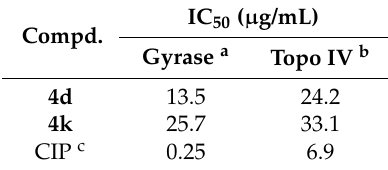
Table 2. Inhibitory effects of selected compounds against DNA gyrase and topoisomerase IV. Compd.